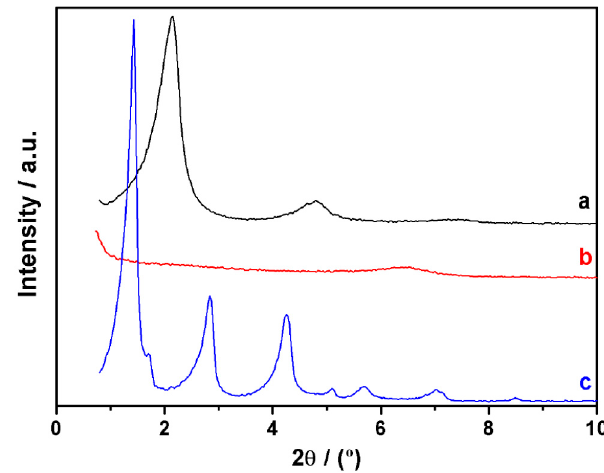
Figure 8. XRD patterns of ( a ) UVM-L12, ( b ) collapsed surfactant-free UVM-L12, and ( c ) rebuild expanded phase using C18 as a surfactant.